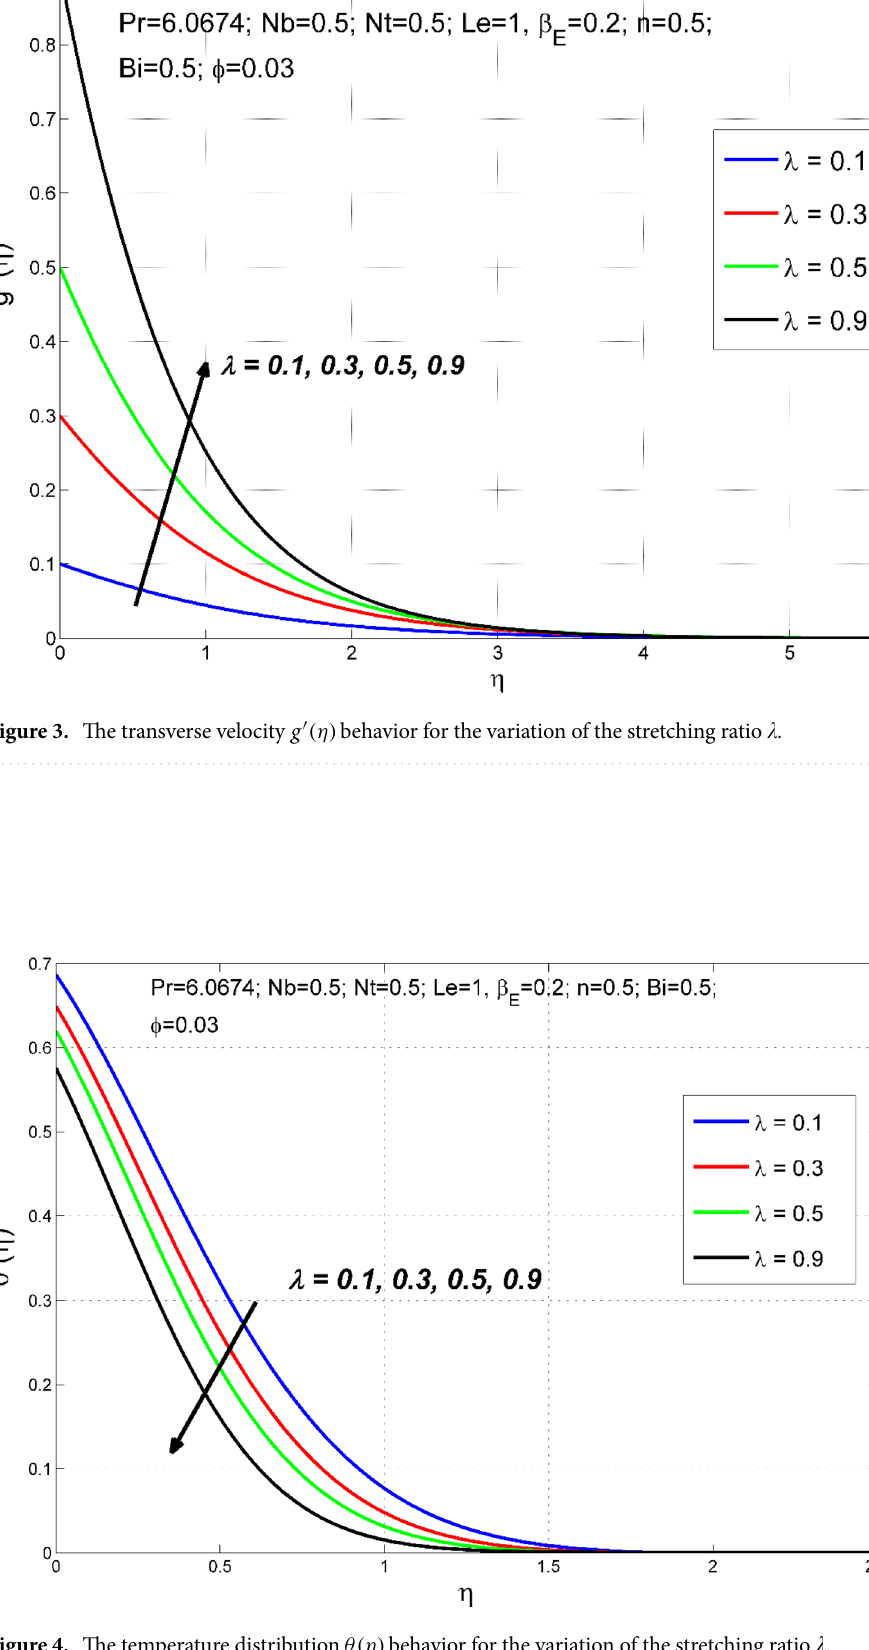
Figure 4. The temperature distribution θ(η) behavior for the variation of the stretching ratio (cid:31)